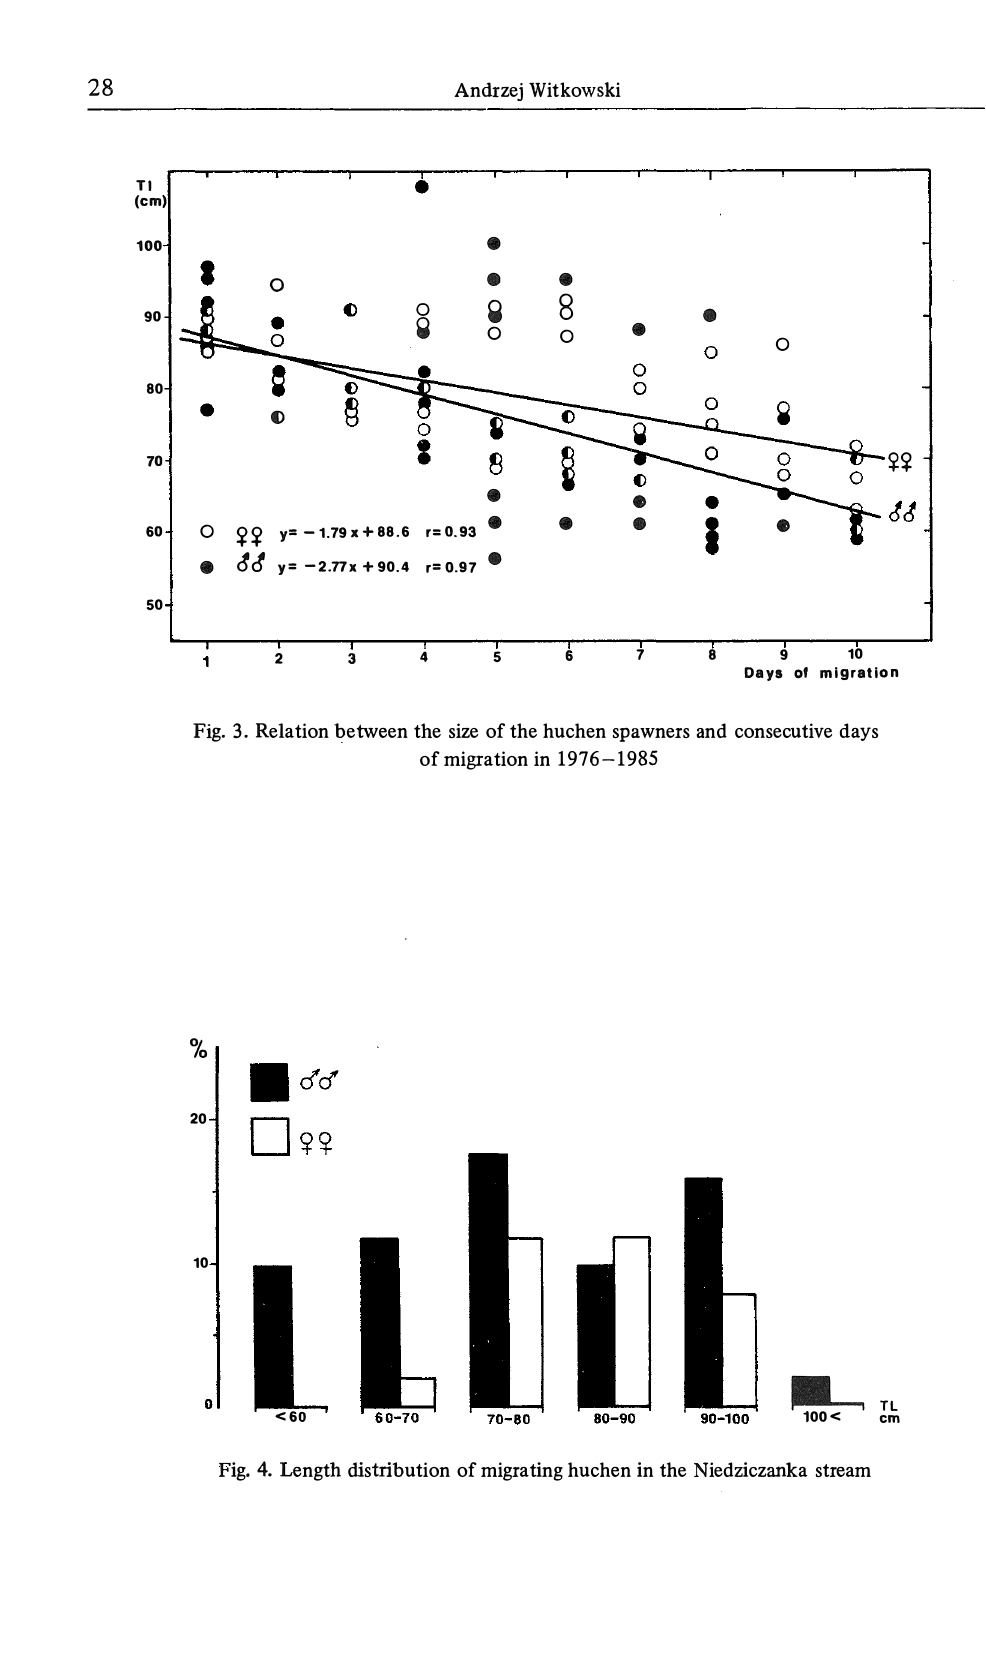
Fig. 4. Length distribution of migrating huchen in the Niedziczanka